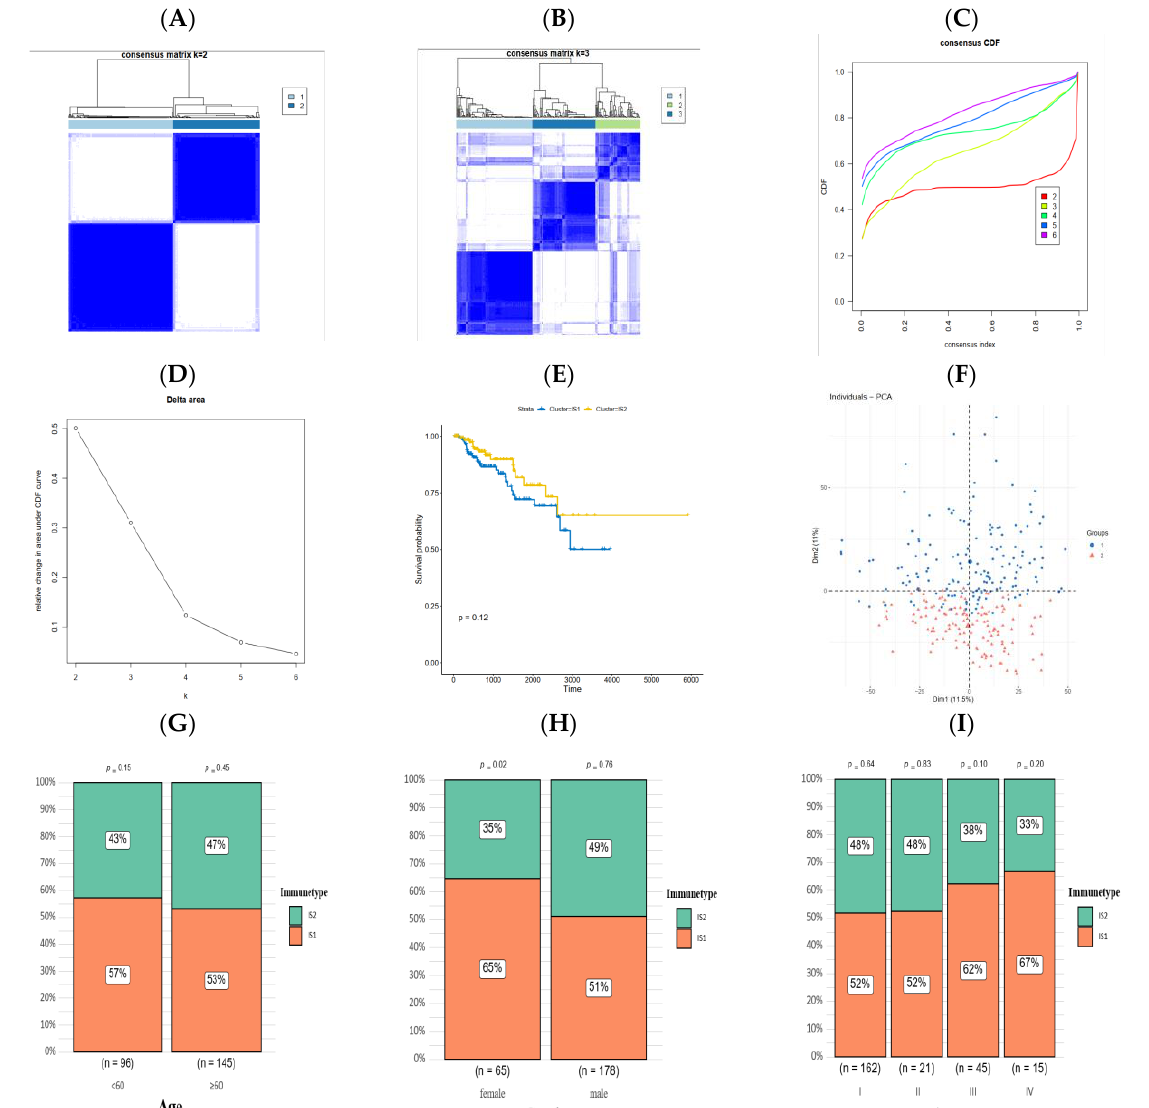
Figure 5. Identification of immune subtypes in individuals with PRCC. ( A ) Consensus clustering matrix of PRCC samples when k = 2. ( B ) Consensus clustering matrix of PRCC samples when k = 3. ( C ) Consensus clustering CDF when k was in the range of 2 to 6. ( D ) Relative area under CDF curve changed when k was in the range of 2 to 6. ( E ) Survival analysis between OS and two groups. ( F ) The prognosis discrepancy of patients in the two clusters. ( G – I ) Different proportions of immune subtypes in age, gender, and stage groups.